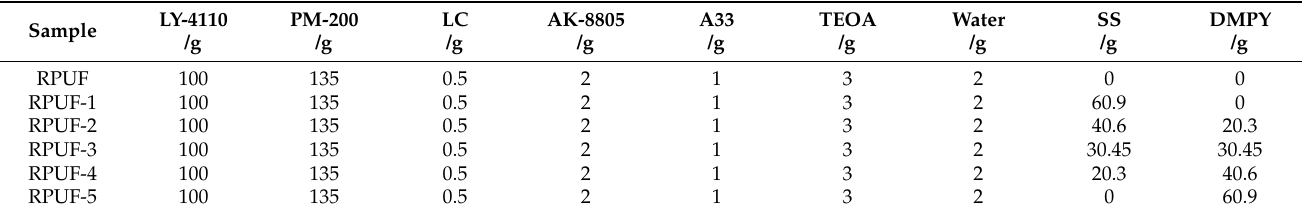
Table 5. Composition of RPUF and RPUF-R